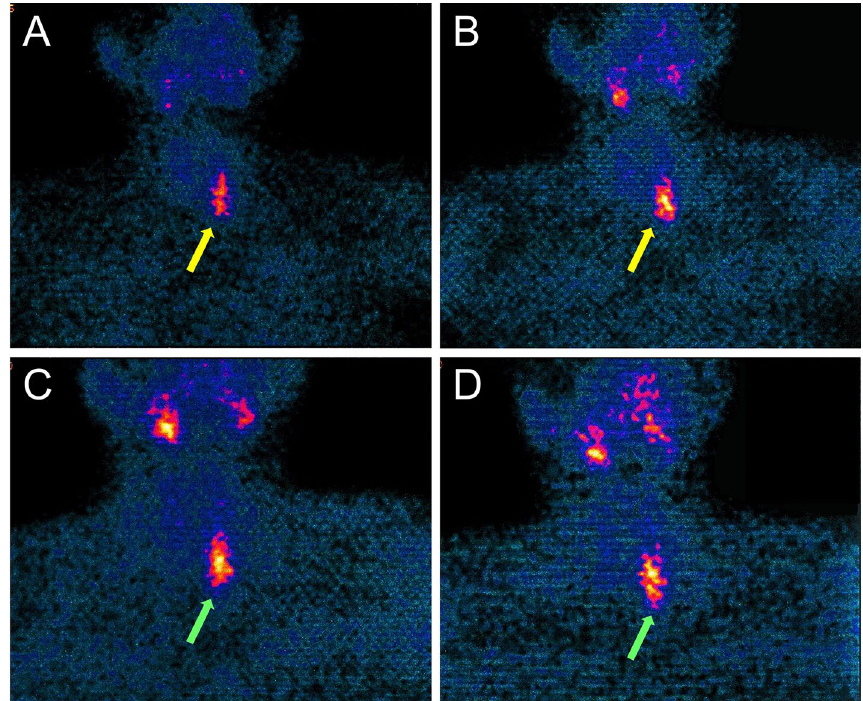
Fig. 2 Early ( A , B ) and late ( C , D ) parathyroid SPECT imaging with [ 99m Tc]Tc-sestamibi suggesting the presence of hyperfunctioning parathyroid tissue in the lower left parathyroid lodge (yellow and green